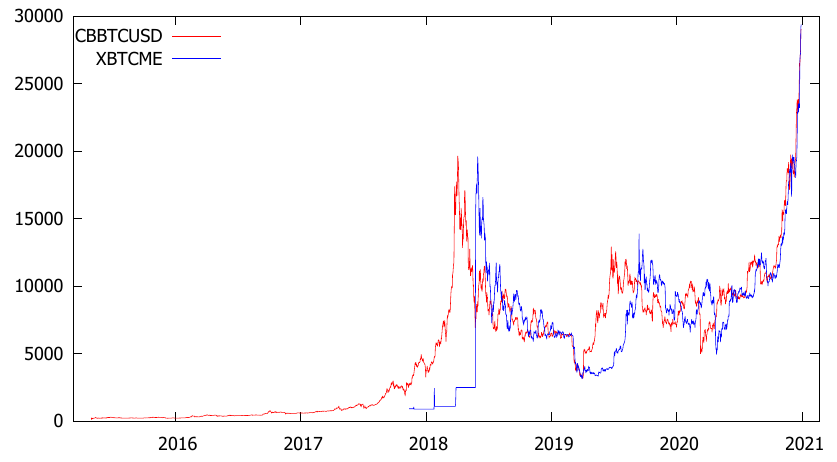
Figure 2. Coinbase Bitcoin spot price (red) and CME Bitcoin futures of maturity, December 2020 (blue) in US